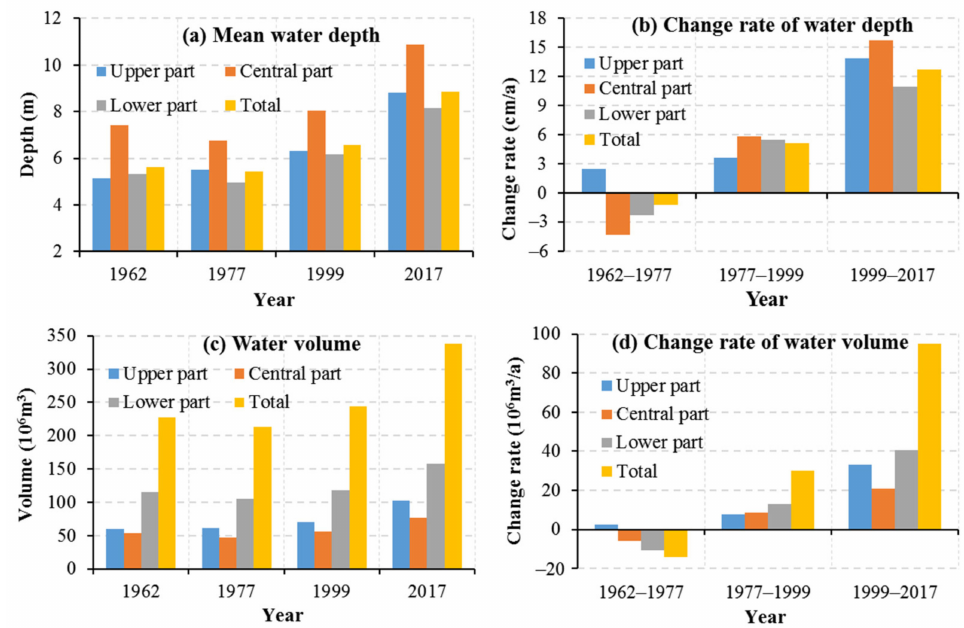
Figure 6. Changes in water depth and volume in different zones from 1962 to 2017. ( a ) Mean water depth below 0 m isobaths, ( b ) water volume below 0 m isobaths, ( c ) change rate of water depth, and ( d ) change rate of water